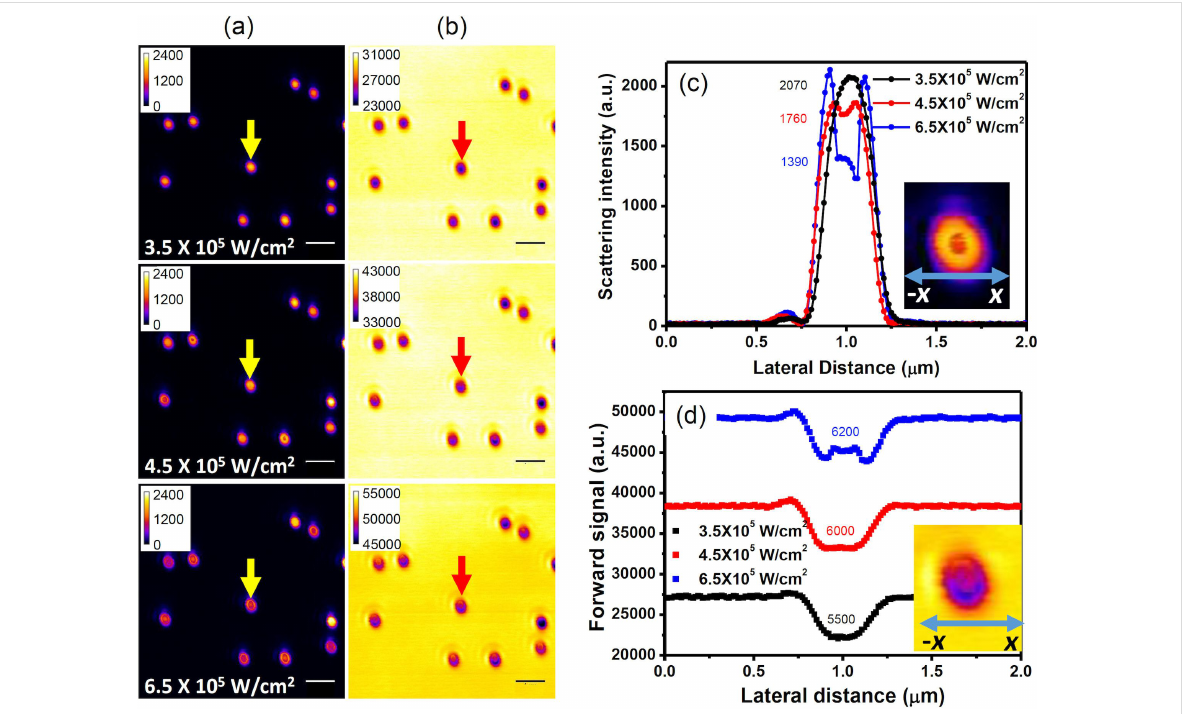
Figure 3: (a) Backward path and (b) forward path images of the same ten spherical gold nanostructures shown in Figure 2 recorded at larger excita- tion intensities. The x -scan signal profiles of the spherical gold nanostructure marked by arrows in (a) and (b) are given in (c) and (d), showing the nonlinear responses of the backscattering and attenuation signals as functions of the excitation intensity. The number on each peak represents the signal height at the center of the PSF (positive for backscattering and negative for attenuation). The scale bar is 1 µm.